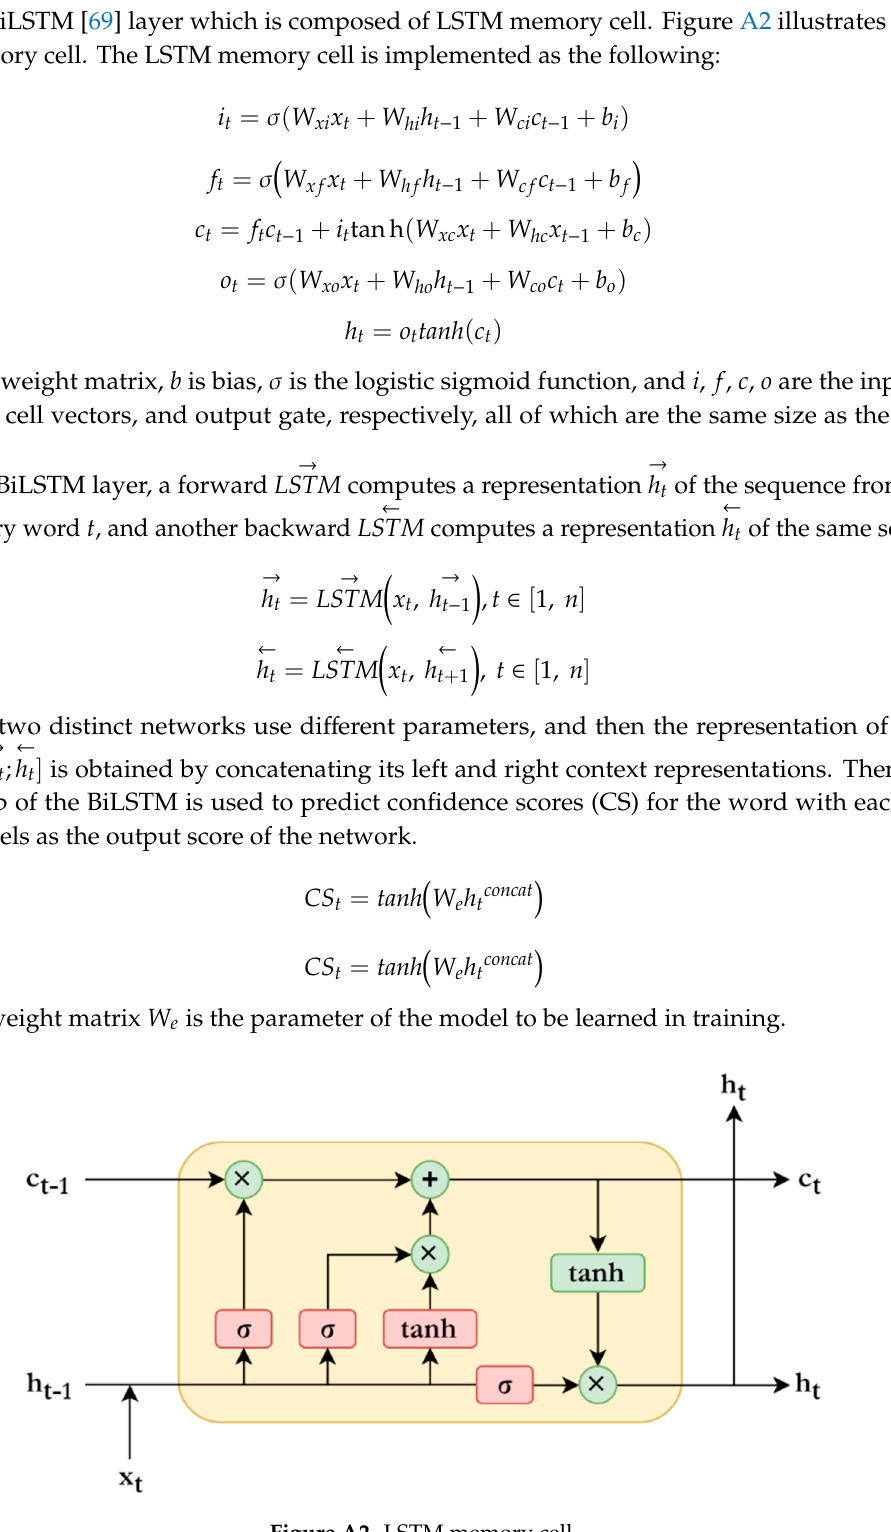
Figure C1. LSTM memory cell. Figure A2. LSTM memory